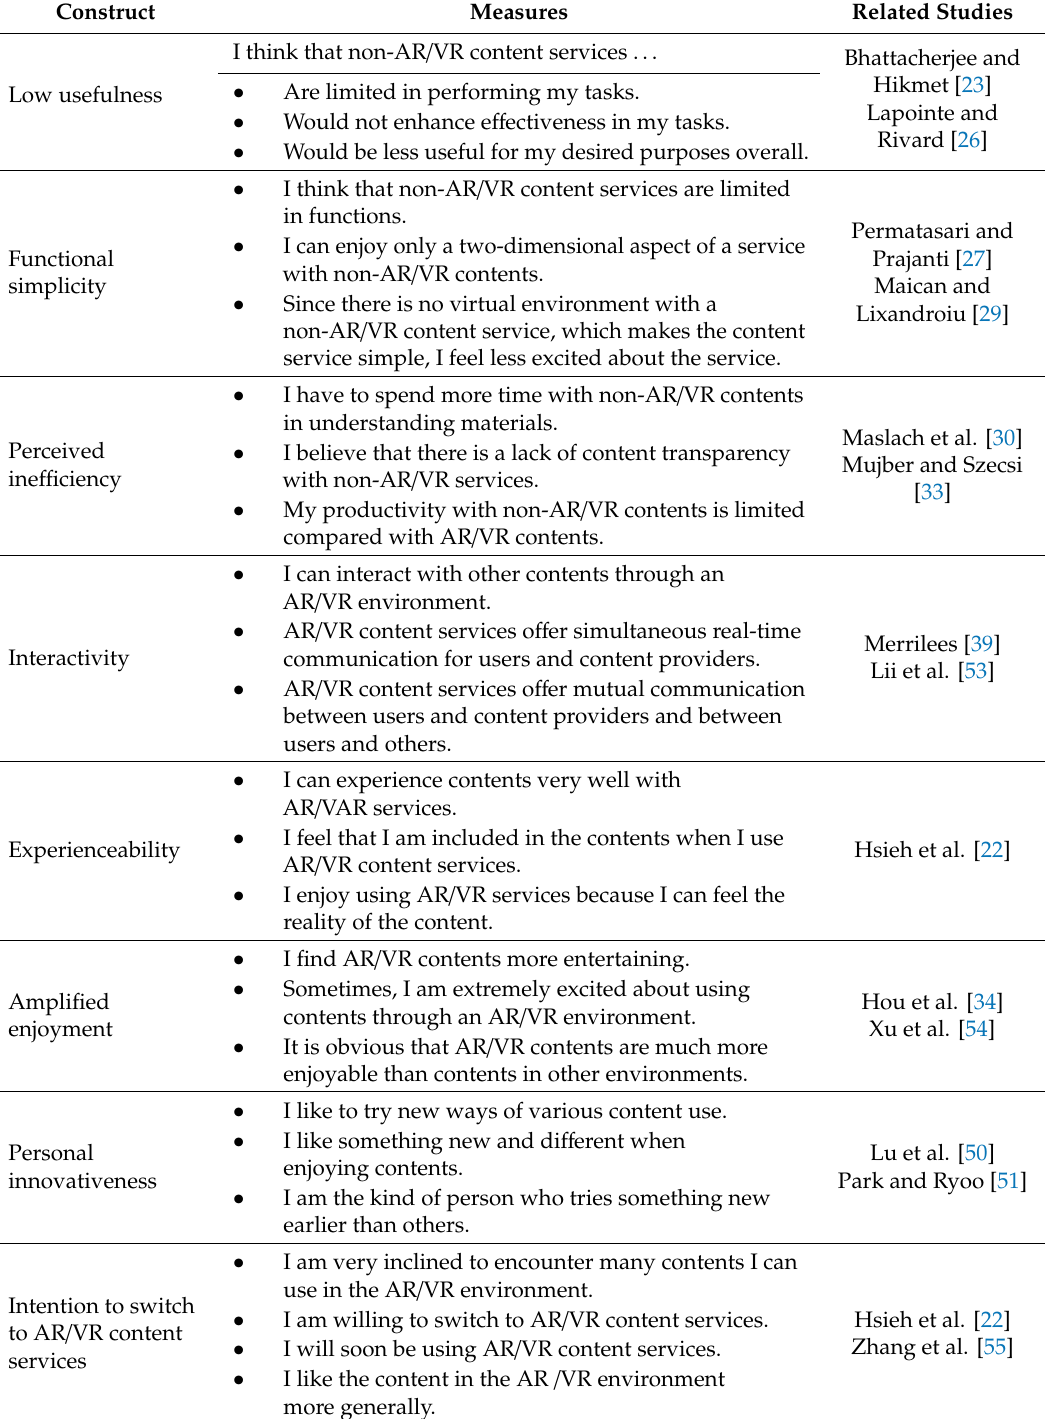
Table 2. Measures and related